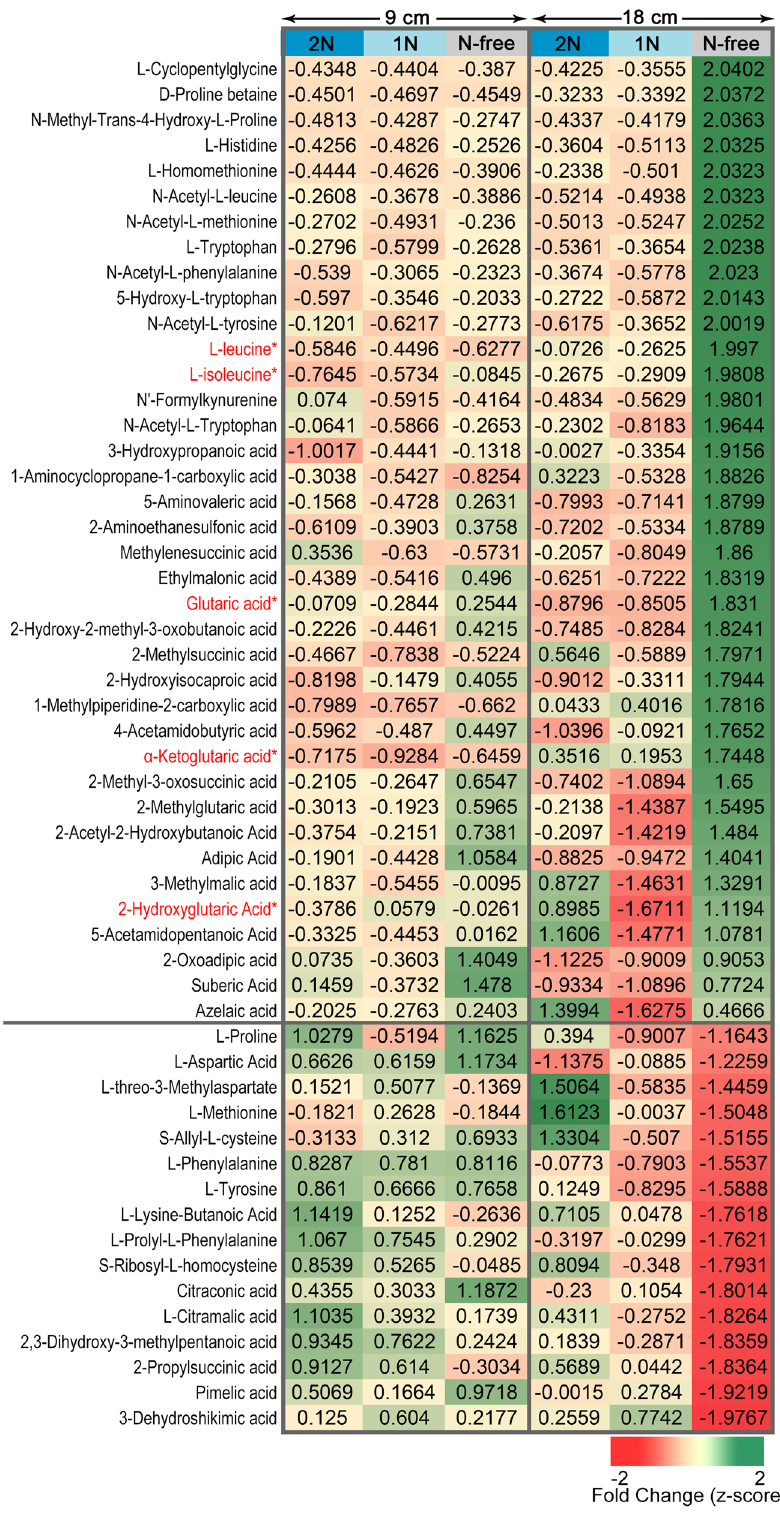
Fig. 5 Alteration in the contents of amino acids and derivatives and organic acids in etf β relative to WT is exacerbated by a decrease of N supply. Fold changes of metabolite content in etf β relative to WT are standardized to ( − 2, 2) by z -score. Asterisks at the upper right of the metabolite names marked in red indicate known metabolic substrates of the ETF/ETFQO system. Metabolites above the black line are signi fi cantly higher in etf β , and metabolites below the black line are markedly lower in etf β . The color bar on the top of the heatmap indicates N concentration: bright blue, 2 N; wathet blue, 1 N; and gray, N-free. Each color block represents the fold change of the corresponding metabolite content in etf β relative to WT under the same N concentration at the same stage (panicle length of 9 cm, the left three columns; panicle length of 18 cm, the right three columns). Three independent biological repeats were performed. Source data are provided in the Source Data fi